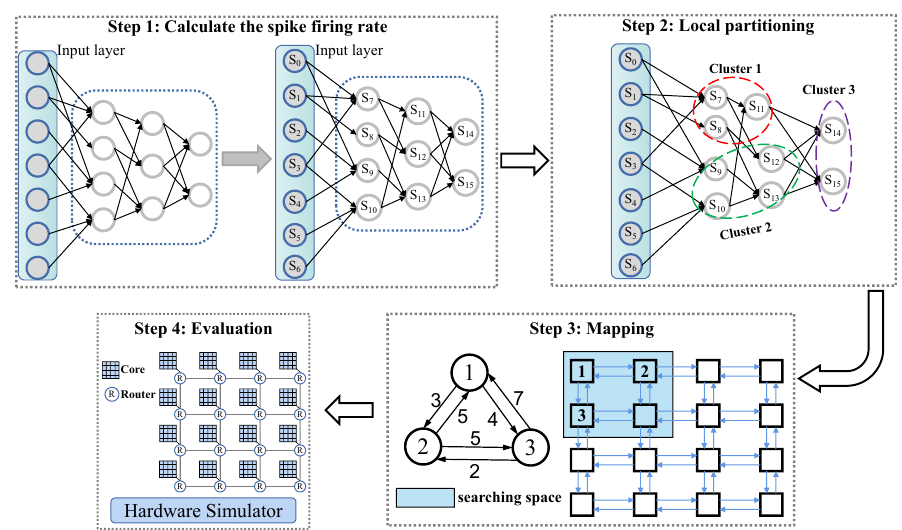
Figure 4. High-level overview of our proposed